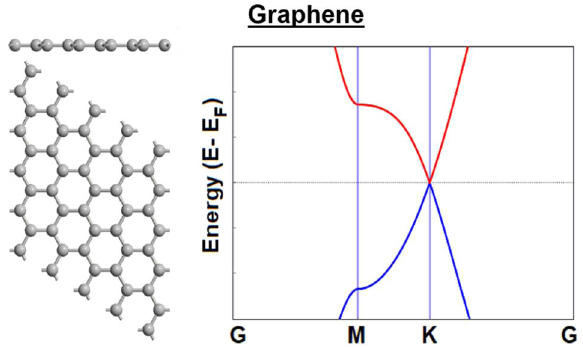
Fig. 4 Structure and Electronic Properties of Graphene. The side- view and top view representations (5 × 5 × 1 Supercell) of the monolayer Graphene and its energy-crystal wave vector (E-k) dispersion relations where the conduction band and valance band are marked in red and blue,